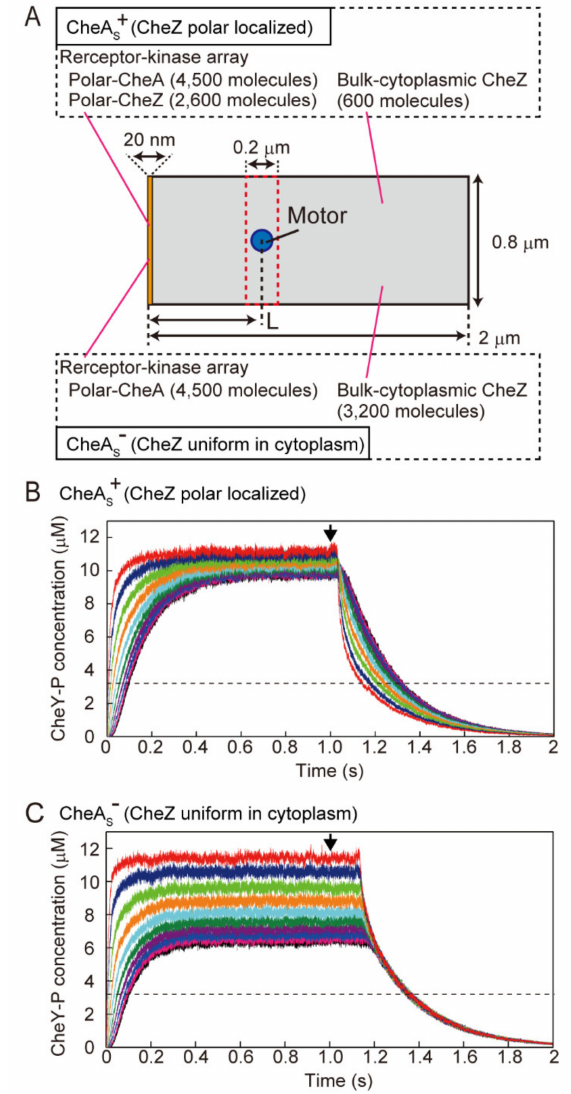
Figure 5. Simulation for the change in CheY-P concentration in the presence and absence of polar localization of CheZ. ( A ) A scheme depicting the method used to estimate the CheY-P concentration around a flagellar motor. Distance between the polar receptor-kinase array and motor shown as L. The number of CheY-P molecules within a 0.2- µ m-long and 0.8- µ m-wide area surrounding a motor (red dotted area) was counted and was converted to the concentration (see Materials and Methods). ( B ) Simulation for a CheA S + cell when the rate constant for dephosphorylation of CheY-P (k 3 ) of polar localized CheZ was 4.0 × 10 6 M − 1 s − 1 . Distances between the cell pole and the motor are, in µ m, 0.05 (red), 0.2 (dark blue), 0.4 (green), 0.6 (orange), 0.8 (cyan), 1.0 (green), 1.2 (violet), 1.4 (blue), 1.6 (magenta), and 1.8 (black), respectively. At each position, the average trace from 13 simulations is shown. ( C ) Simulation for a CheA S − cell when the k 3 value for cytoplasmic CheZ is 1.6 × 10 6 M − 1 s − 1 . Distances from the cell pole and colors are the same as for the CheA S + cell. At each position, the average trace from 10 simulations is shown. The results of the simulation using other k 3 values are shown in Figure S4. In both simulations, the activity of CheA was turned on at 0 s, and a plateau level of CheY-P was reached within 1 s. CheA activity was turned o ff at 1 s (downward